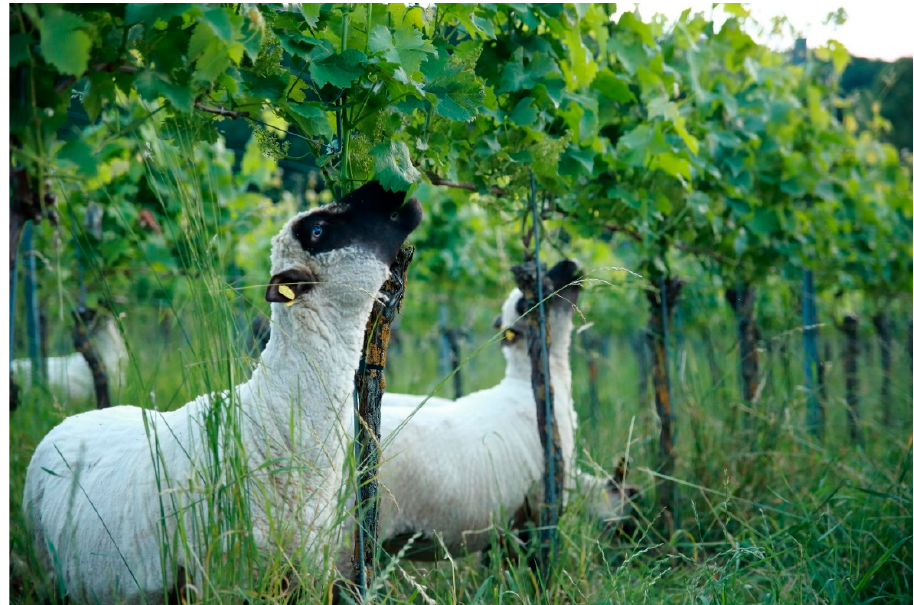
Figure 1. Shropshire sheep clearing the grape zone (leaf plucking) in the widely used Guyot vine training system. Here, a trellis (espalier) system is used to anchor the foliage area. The lowest wire is decisive for the height of the grape zone.